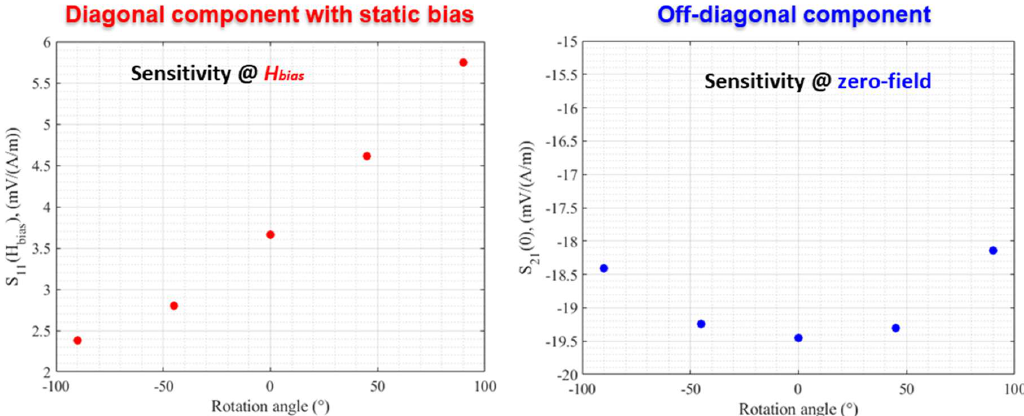
Figure 8. Change in the sensitivity of the diagonal and off-diagonal components as a function of the rotation angle.